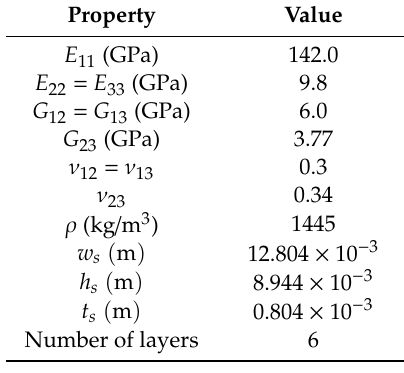
Table 2. The geometrical and material properties of the composite rectangular spar-box.